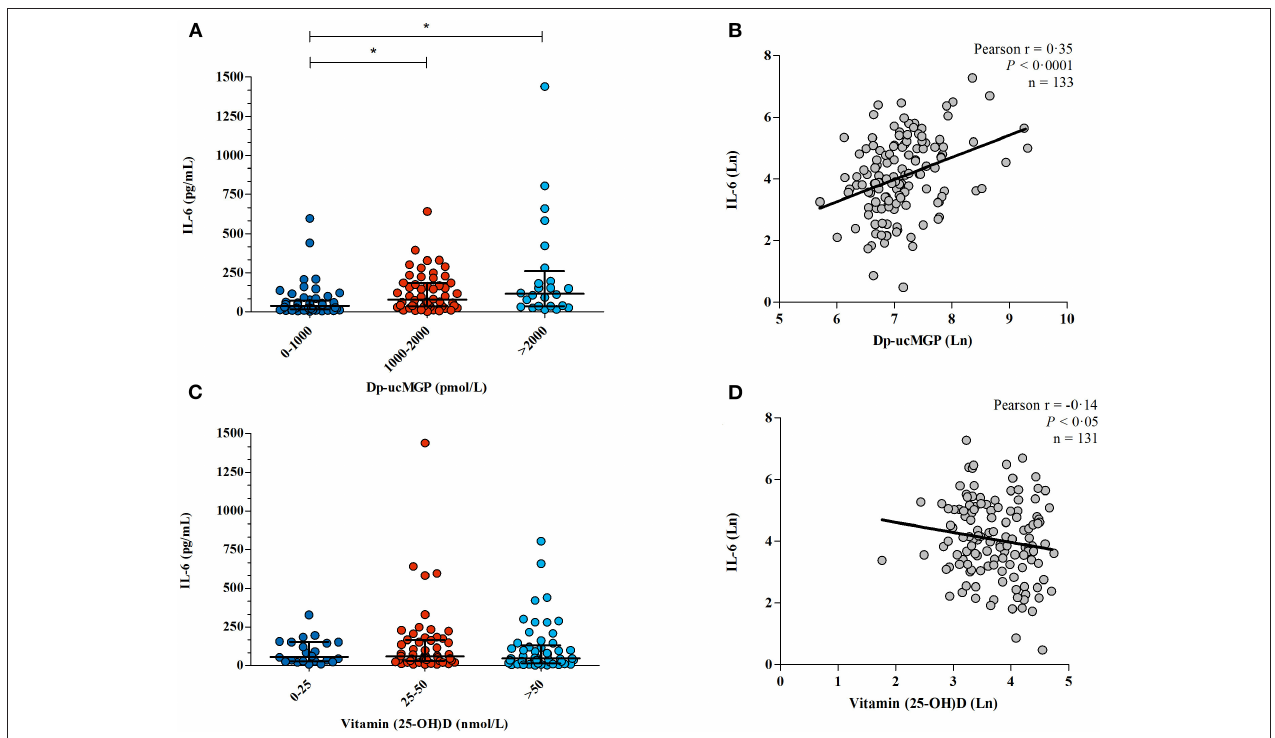
FIGURE 3 | The association between vitamin K /vitamin D and IL-6. (A) Dp-ucMGP and IL-6 were measured in 133 COVID-19 patients. Patients were separated into three categories, mild (dp-ucMGP < 1,000 pmol/L), moderate (dp-ucMGP between 1,000–2,000 pmol/L) and severe vitamin K deficiency (dp-ucMGP > 2,000 pmol/L). *Significant difference in IL-6 levels was found between the dp-ucMGP groups 0–1,000 pmol/L and 1,000–2,000 pmol/L. (B) Correlation between IL-6 and dp-ucMGP, both log transformed. Line shows the result of a linear regression. (C) Vitamin 25(OH) D and IL-6 were measured in 131 COVID-19 patients. IL-6 levels were compared with different levels of vitamin 25(OH) D. There is no significant difference in IL-6 levels between groups. (D) Correlation between IL-6 and vitamin 25(OH) D, both log transformed. Line shows the result of a linear regression.